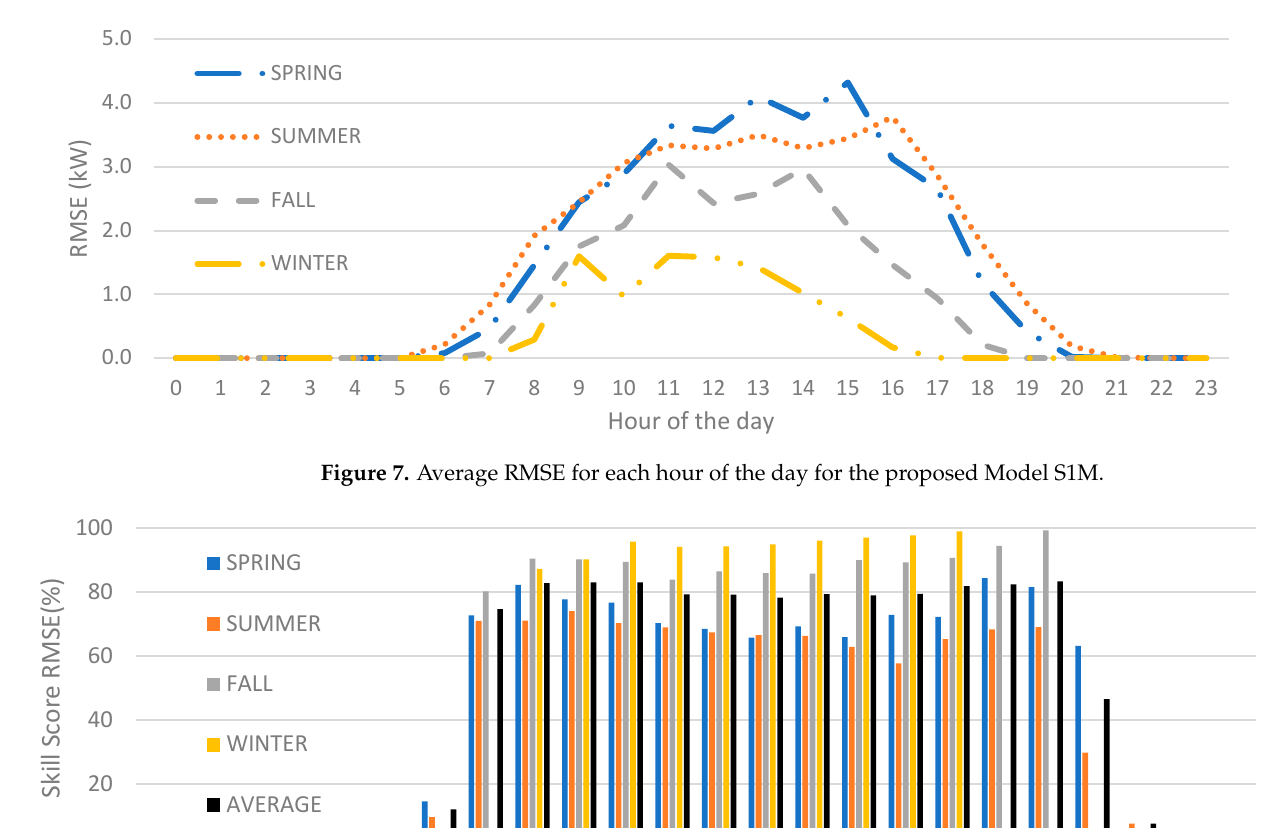
Figure 6. Skill score RMSE of hours ahead predictions of the six CatBoost scenarios.